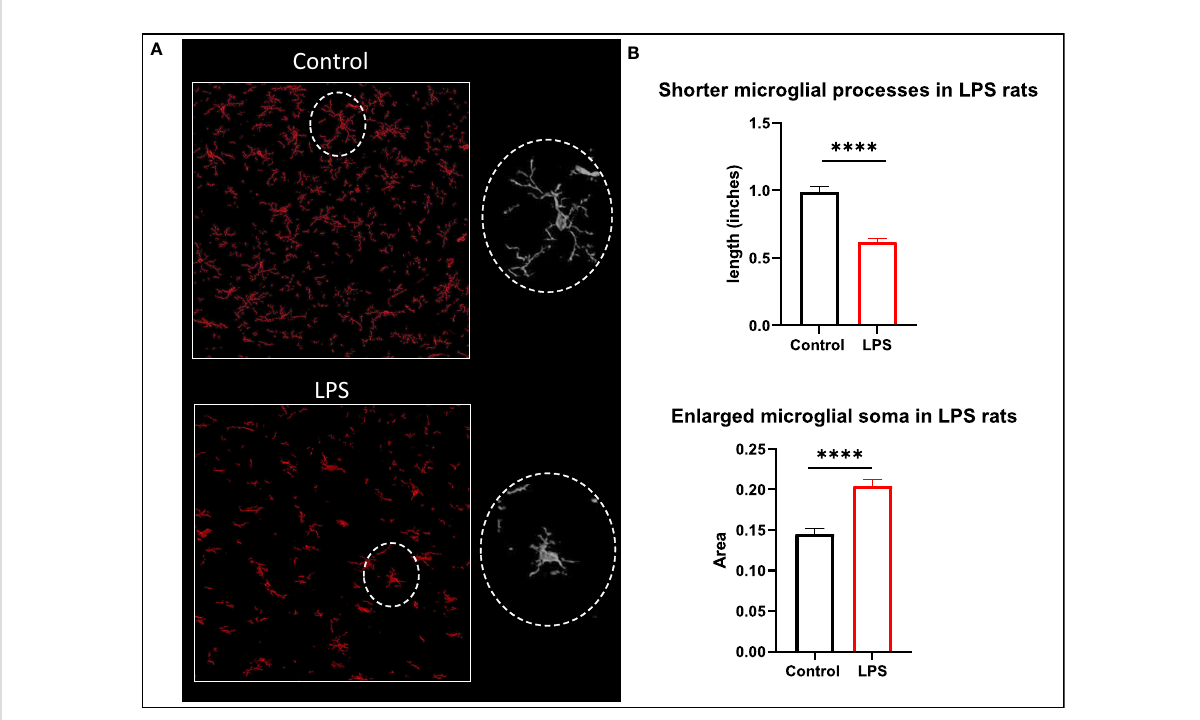
FIGURE 8 Morphological changes in microglia. (A) Representative images of microglia (Iba1 in red) in the corpus callosum of control and LPS treated rats. (B) Animals with systemic in fl ammation (LPS) show shorter microglial processes and thicker cell body compared to controls. Quanti fi cation was performed using the free hand selection tool from Image J to measure the length of 80 microglial processes and to delineate 20 somas from several ROIs in brain sections for each animal (control n=3; LPS-treated n=4). Statistical analysis was performed using unpaired t-test. Mean with SEM are shown. ****p